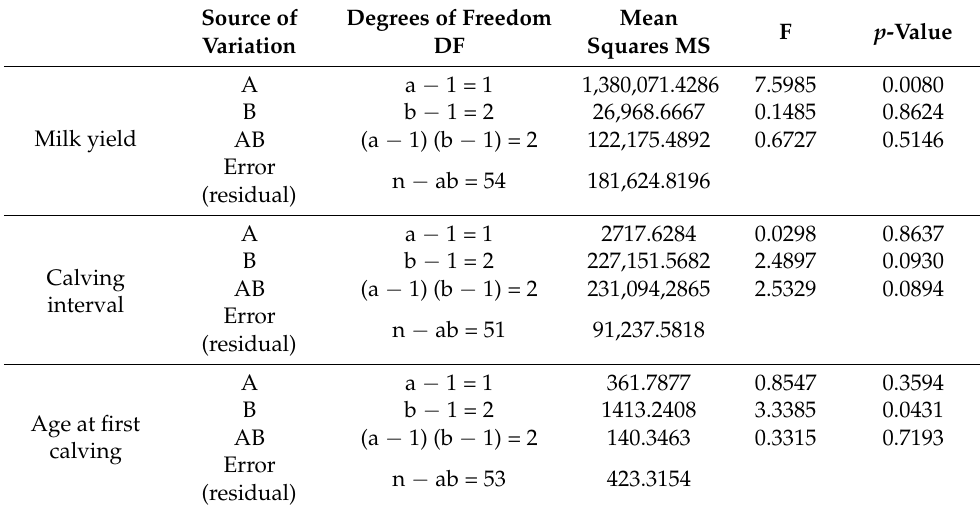
Table 4. Results of two-way ANOVA in testing the dependency of milk yield, calving interval, and age at first calving on (A) milking temperament and (B) body condition score. Source of